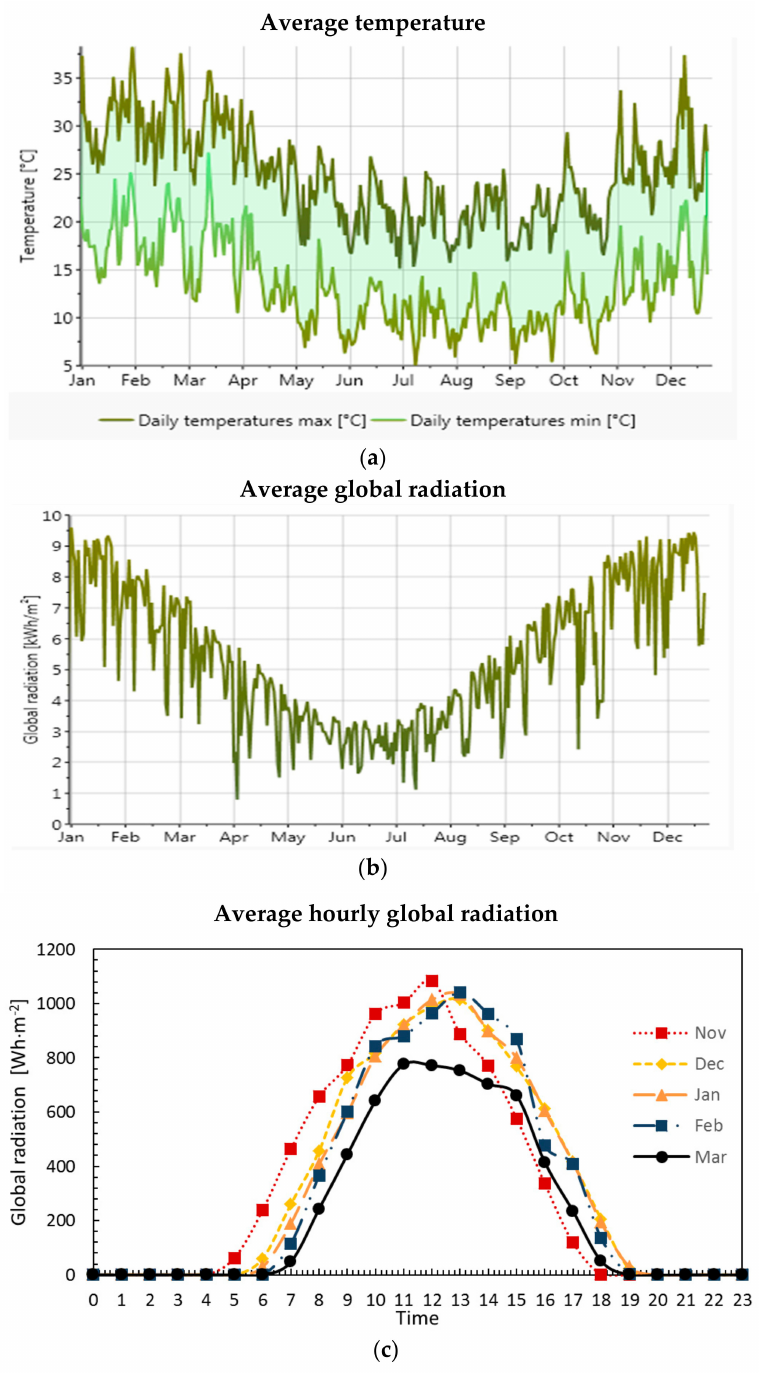
Figure 3. Average variation of ambient temperature and global radiation in Perth (Average temperature ( a ); Average global radiation ( b ); Average hourly global radiation ( c